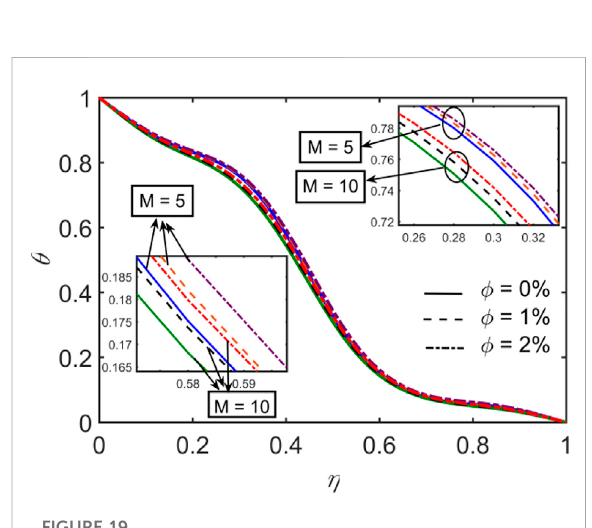
FIGURE 18 The temperature pro fi le θ versus η at x (cid:2) 2 for the fi ve NFs at the four time levels.